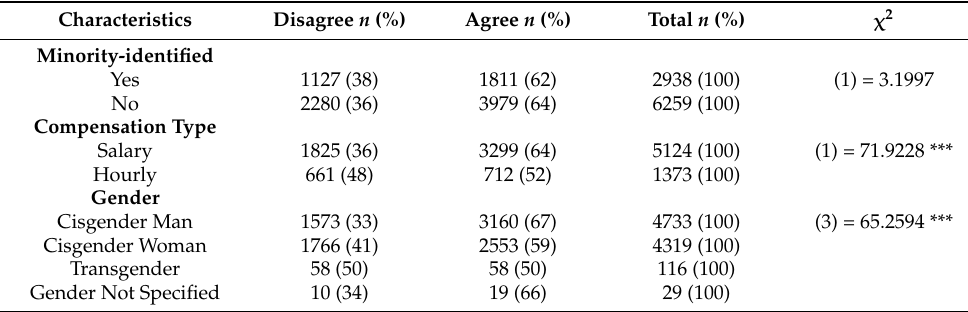
Table 2. Demographic Characteristics and Chi-Square Results (Influence at Work Question).